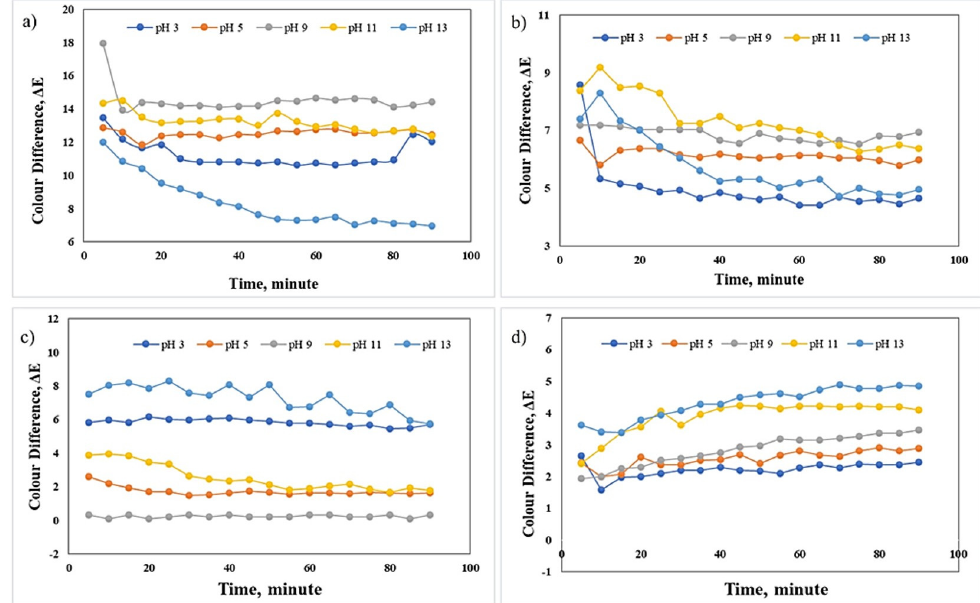
Figure 7. The colour changes of films ( a ) SA − 8%, ( b ) SA − 10%, ( c ) SA − 12%, and ( d ) SA − 14% at different pH of buffer solutions.